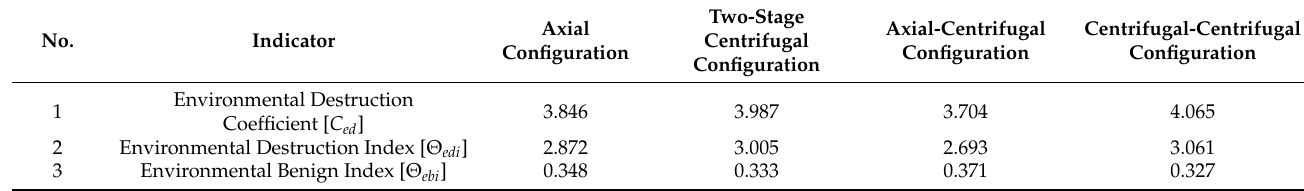
Table 7. Environmental indicators for different GT engines under ISO conditions.